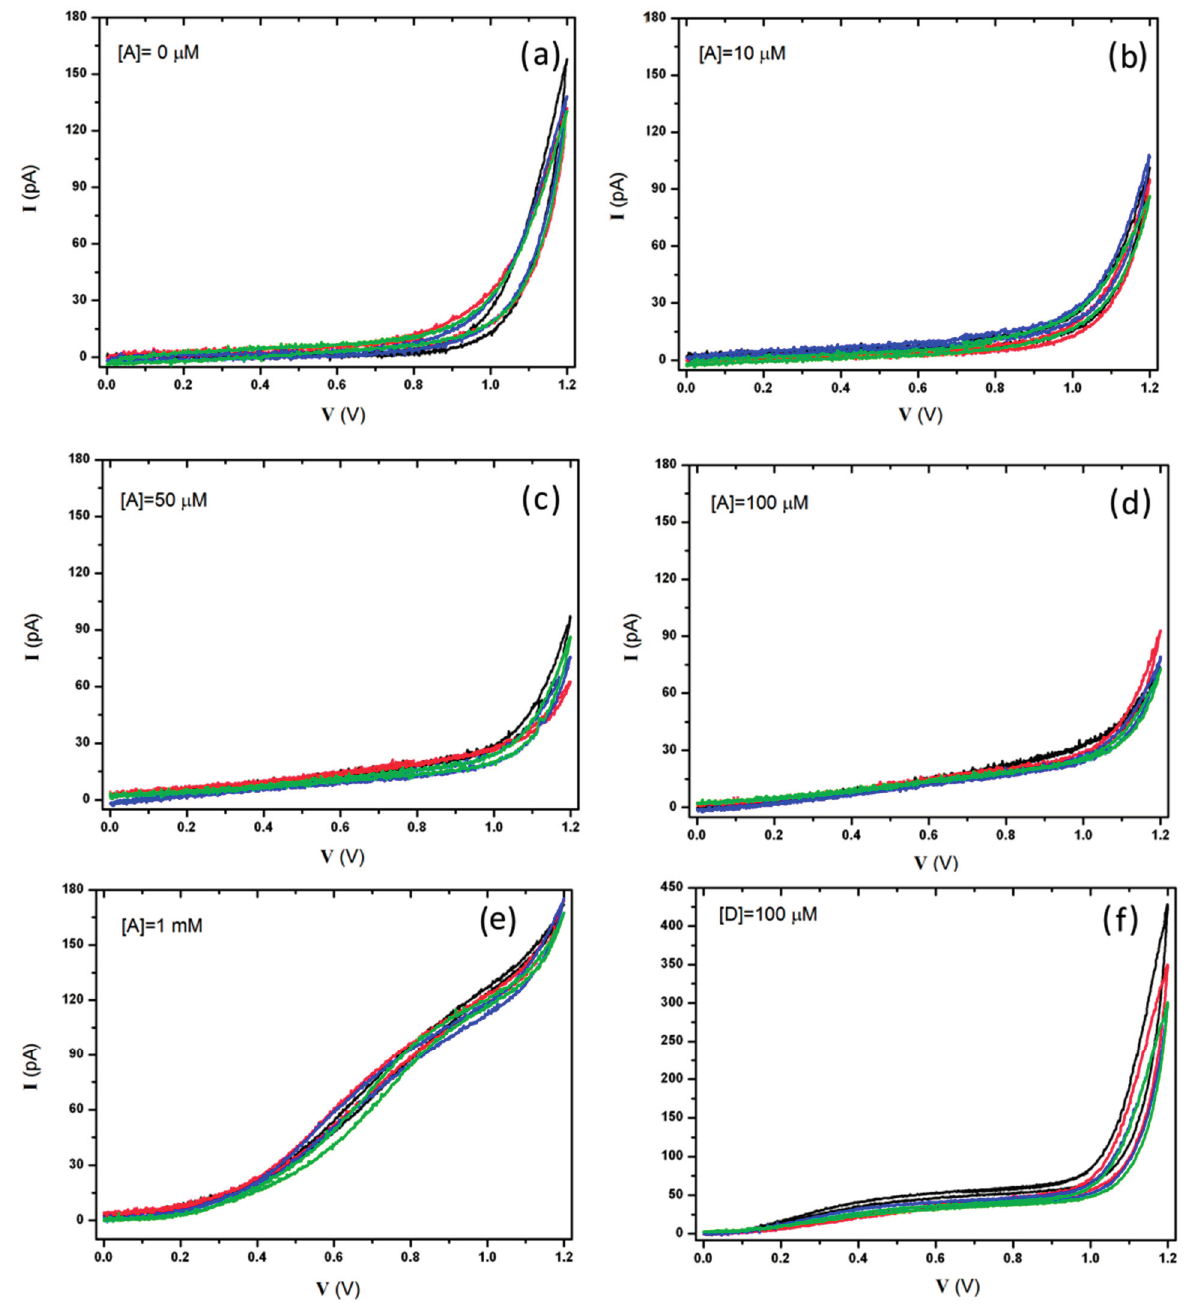
Figure 4. Cyclic voltammetric scans at 20 mV·s − 1 rate of a 0 − 1.2 V voltage applied to four representative sensing microelectrodes (channels #1, #4, #7, #8) with respect to the quasi-reference Ag/AgCl electrode in the presence of Tyrode buffer ( a ) and Tyrode spiked with: 10 μ M adrenaline ( b ); 50 μ M adrenaline ( c ); 100 μ M adrenaline ( d ); 1 mM adrenaline ( e ) and 100 μ M dopamine ( f